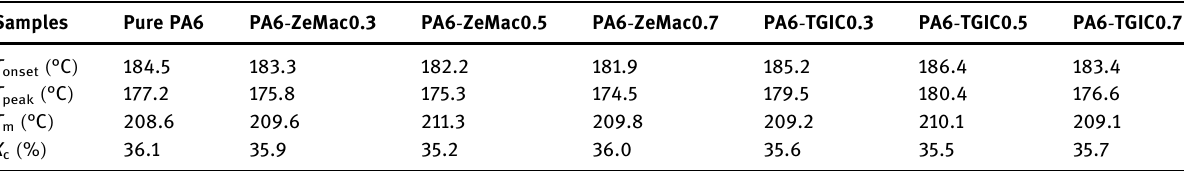
Table 4: Crystallization and melting data of pure PA6 and modi fi ed PA6 Samples